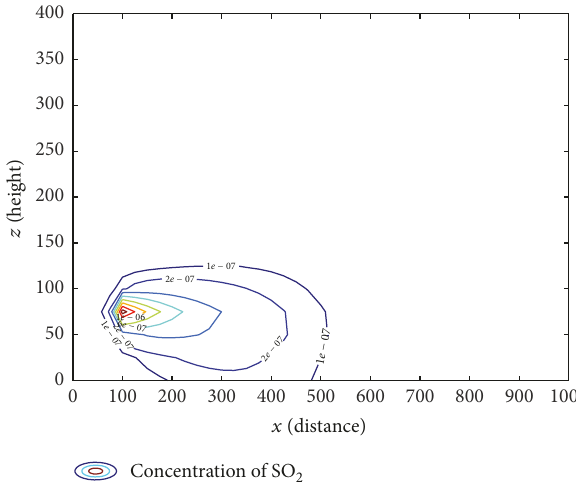
Figure 3: The concentration levels of air pollution after 58 minutes have passed without control system.